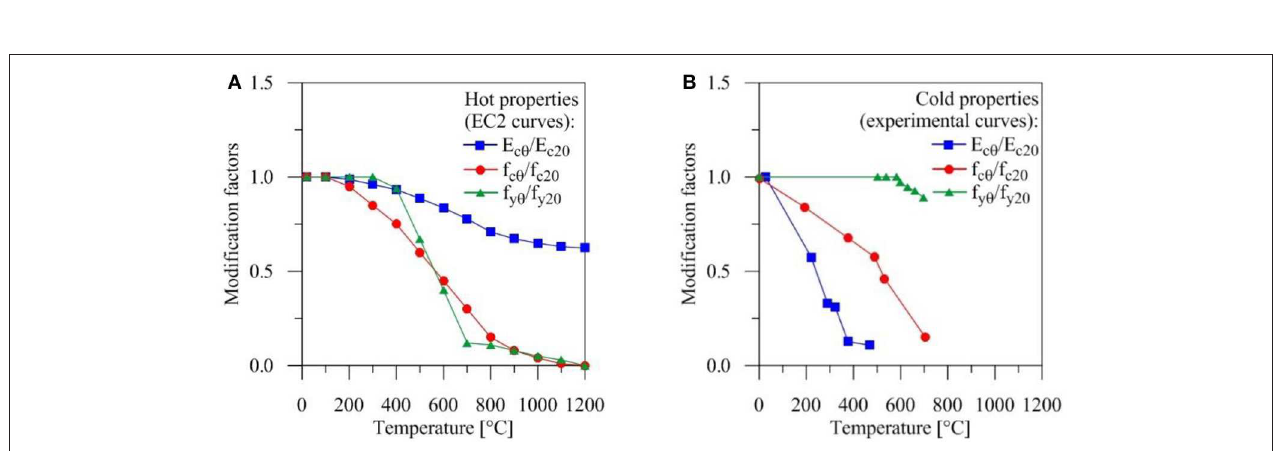
FIGURE 6 | Time-temperature profiles for the cross-section of an interior column exposed to fire at the ground (A,B,C) and first (D,E,F) level of the Collina-Castello school.